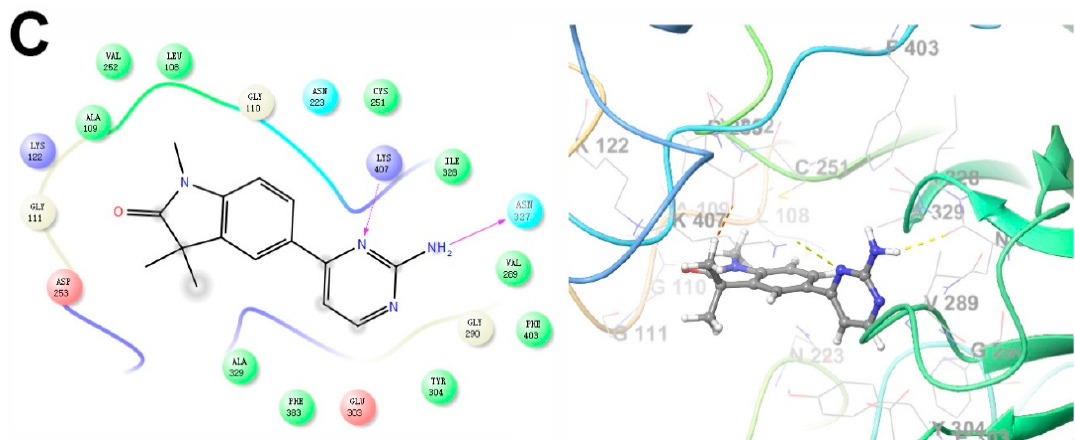
Figure 3. Two-dimensional ( left ) and three-dimensional ( right ) docking models of GAL-012 binding to ( A ) GALT, ( B ) UGP2 and ( C ) AGX1/UAP1. The docking experiments were performed as described previously using Glide (Schrödinger, LLC) [22]. The X-ray crystal structures of human GALT (PDB ID: 5IN3), UGP2 (PDB ID: 4R7P) and AGX1 / UAP1 (PDB ID: 1JVD) was used.